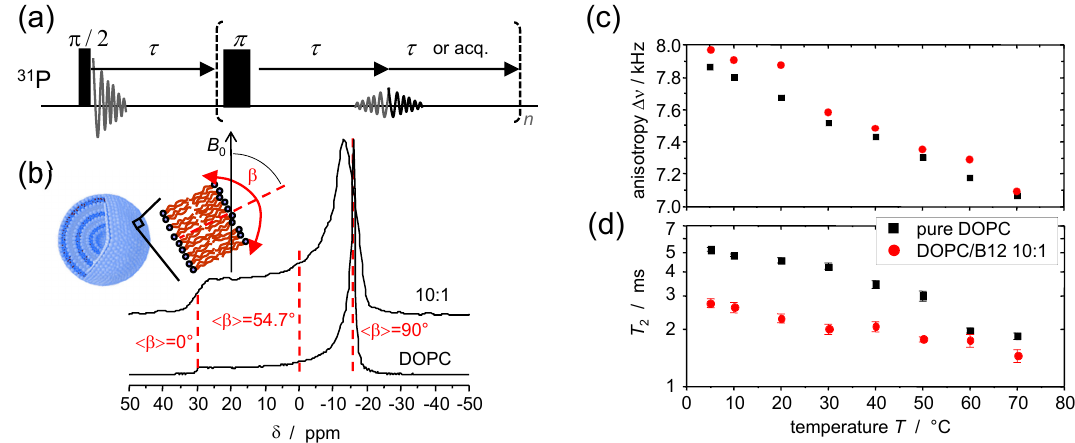
Figure 18. 31 P lineshape and relaxation studies. ( a ) Schematic pulse sequence for Hahn-echo and Carr-Purcell-Meiboom-Gill (CPMG) experiments; ( b ) Static 31 P spectra of MLVs of DOPC, pure and as a 10:1 mixture with B12 taken at 30 ◦ C. The red dashed line indicates the spectral position corresponding the the magic-angle orientation ( (cid:104) β (cid:105) = 54.7 ◦ ) of the membrane normal with δω 0 /2 π , see Equation (2); respect to B 0 ; ( c ) Temperature-dependent width of the spectra ∆ ν = 3 2 ( d ) Temperature-dependent T 2 relaxation times from Hahn-echo experiments evaluated for (cid:104) β (cid:105) ≈ 55 ◦ . All 31 P experiments have to be, and have been, conducted with low-power 1 H